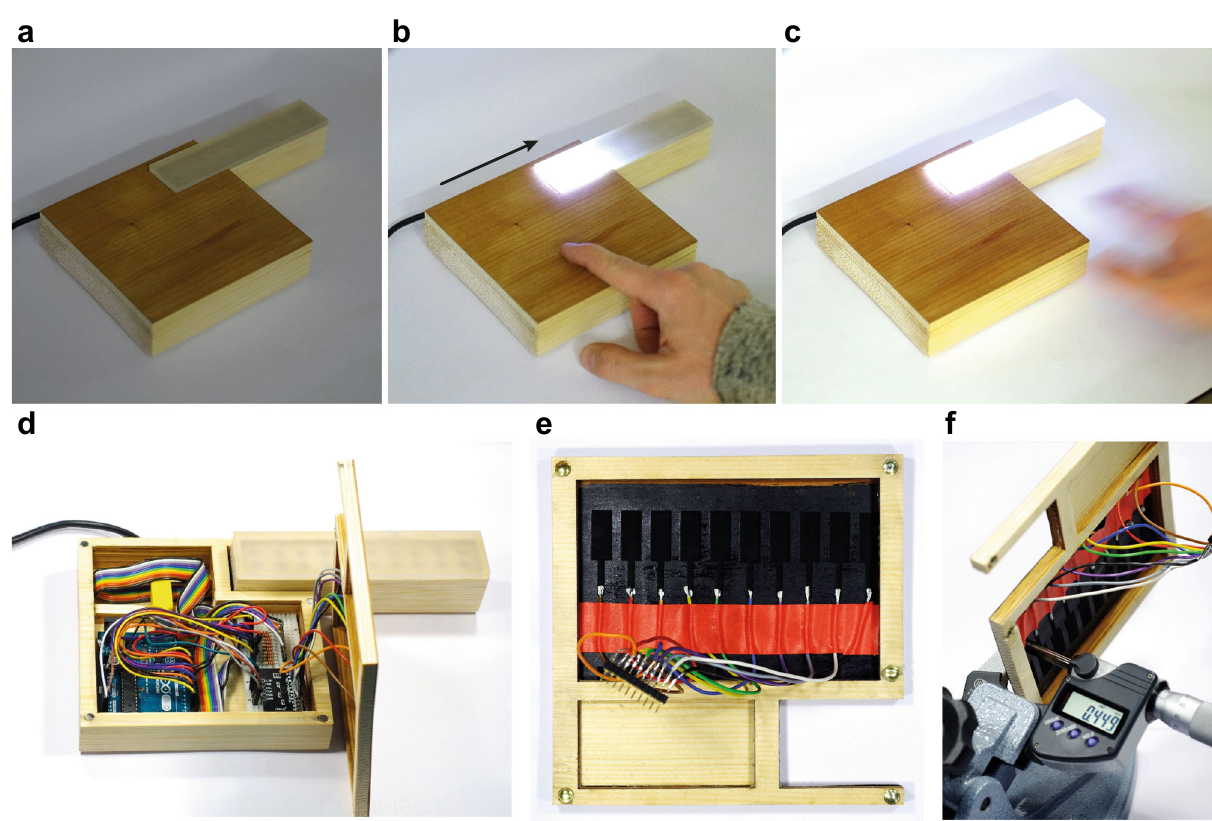
Fig. 5 IC-LIG-Wood touch button panel. Capacitive IC-LIG-wood touch button panel made with a thin wild cherry wood veneer. Image sequence showing that the initially “ off ” ( a ) LED lights can be switched “ on ” ( b , c ) by touching the front native wood veneer surface and moving the fi nger in the direction indicated by the black arrow. Pictures showing ( d ) the open device, ( e ) the rear wood veneer surface with the conductive IC-LIG touch buttons. f Demonstration of how thin the engraved veneer is (maximum thickness 450 µ